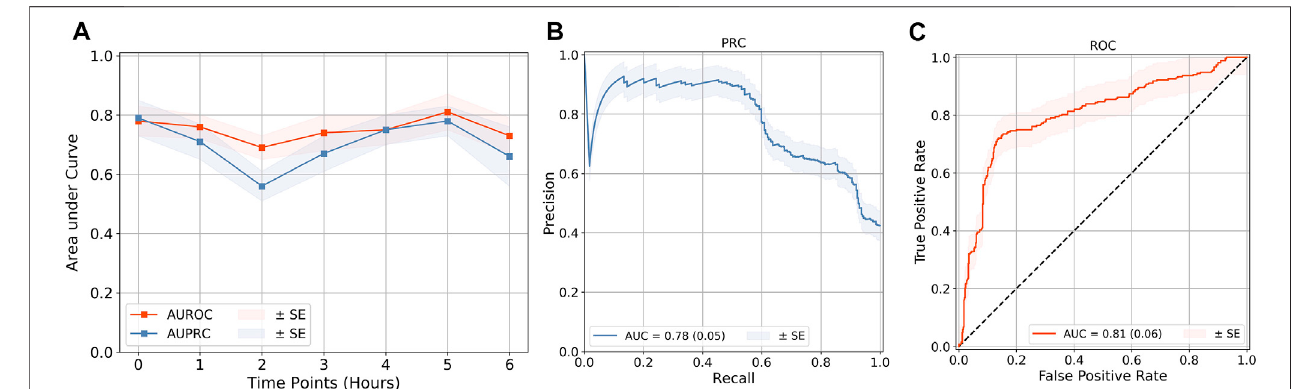
FIGURE 4 | Quality evaluation on the LSTM model. (A) Quality evaluation of the LSTM time-series classi fi cation models at lead points of up to 6 h. The best performance of (B) AUPRC and (C) AUROC was obtained at a 5-h prediction. The rest of the performance metric results are demonstrated in Supplementary Figure S2 . The results of all are shown in Table 2 . The standard error (SE) for each is calculated from cross-validation, by taking k = 10.